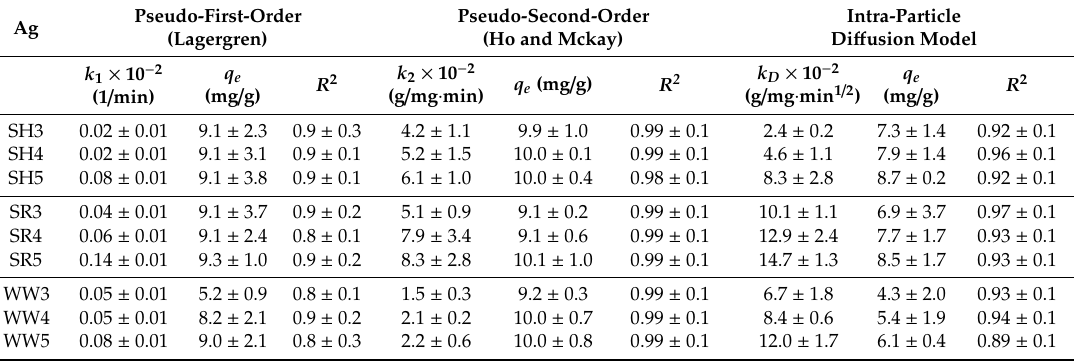
Table 3. Parameters of the Ag adsorption kinetics calculated on the basis of the kinetic models with standard deviations ( n = 3): SH3 (sunflower husks, 300 ◦ C), SH4 (sunflower husks, 400 ◦ C), SH5 (sunflower husks, 500 ◦ C), SR3 (sunflower husks + rapeseed pomace, 300 ◦ C), SR4 (sunflower